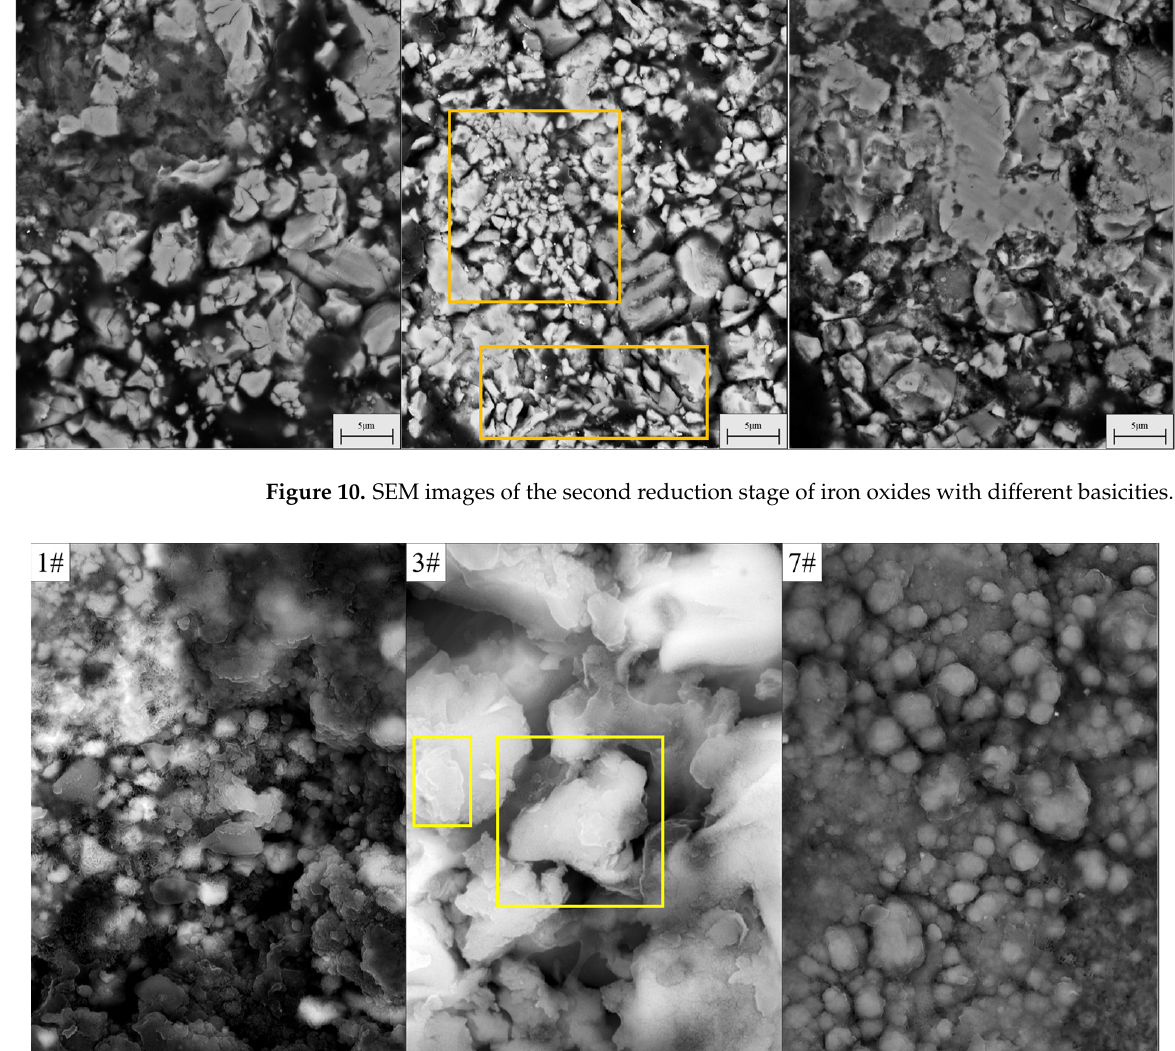
Figure 10. SEM images of the second reduction stage of iron oxides with different basicities.